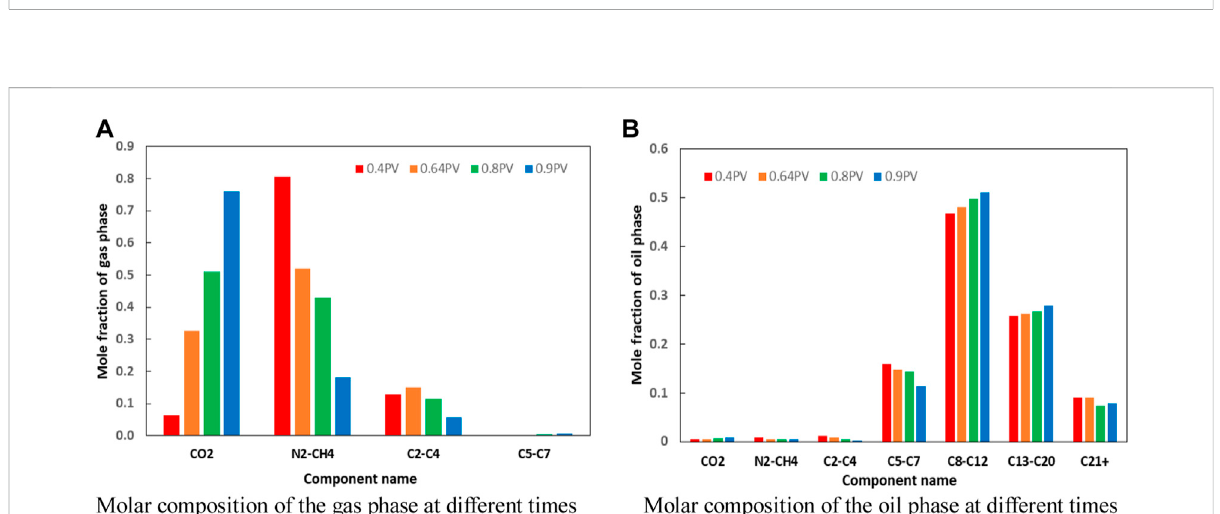
FIGURE 6 Molar composition at different times. (A) Molar composition of the gas phase at different times and (B) molar composition of the oil phase at different times.